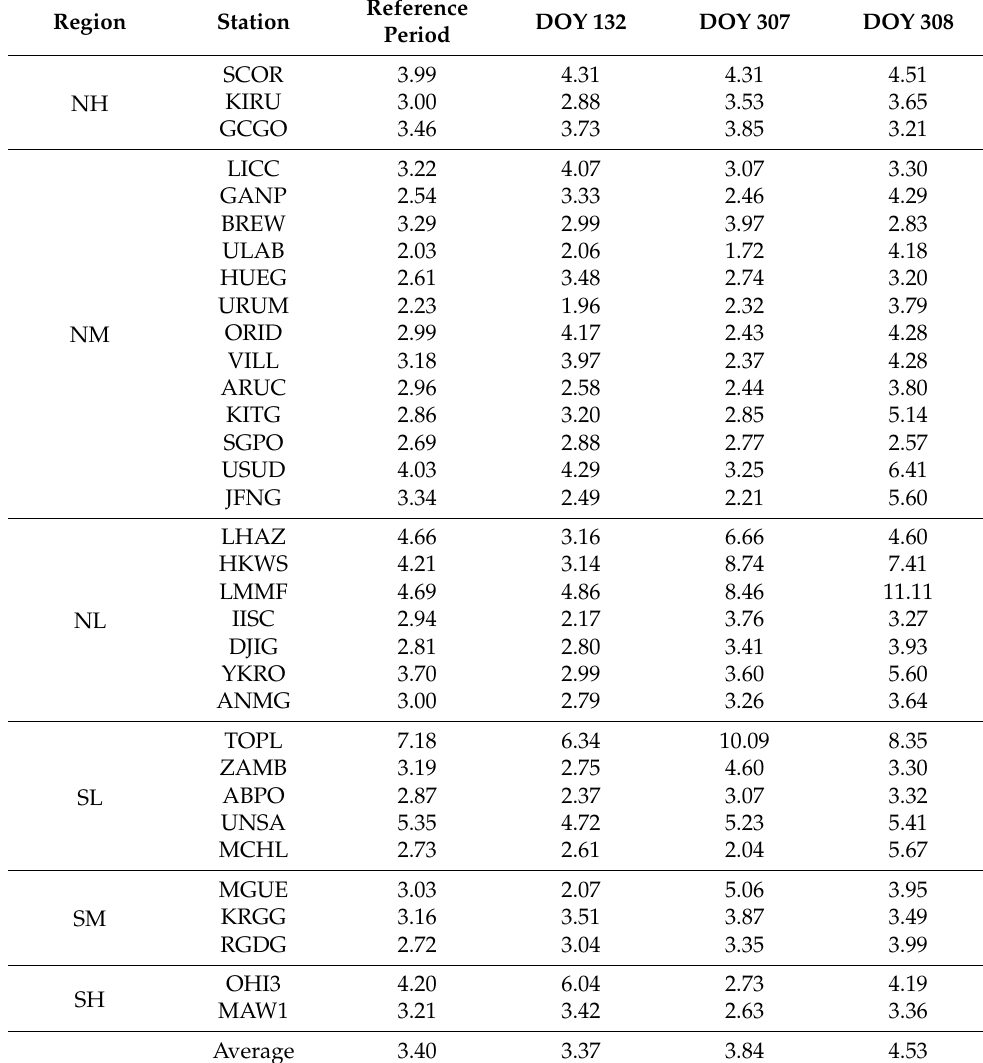
Table 6. 3D positioning accuracy during reference periods and strong geomagnetic storms for BDS + BDGIM (unit: m). N stands for Northern Hemisphere, S for Southern Hemisphere, H for High Latitude (60~75 ◦ ), M for Mid Latitude (30~60 ◦ ), L for Low Latitude (0~30 ◦